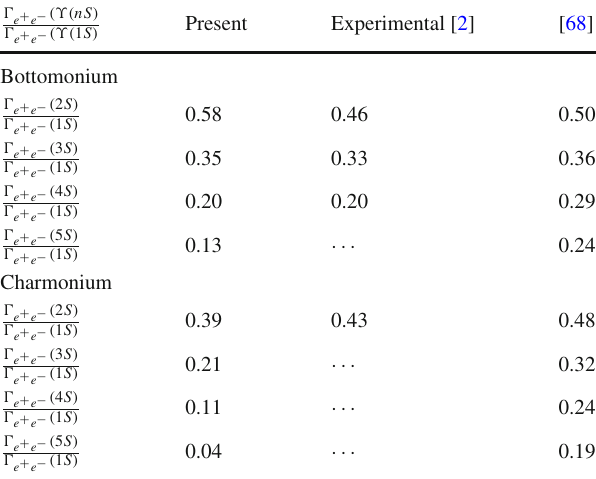
Table10 Theratiosof (cid:17) ee ( nS ) (cid:17) ee ( 1 S )